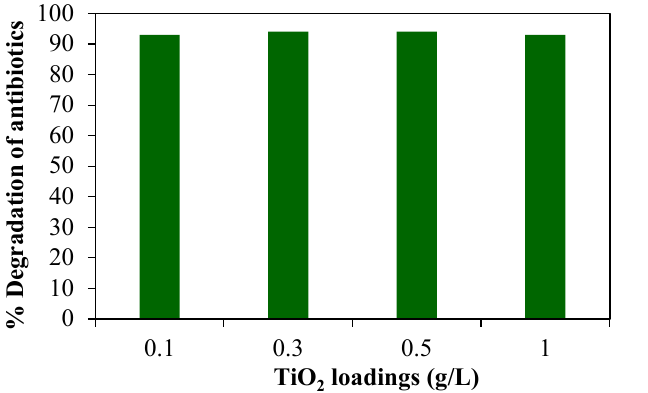
Figure 10. The effect of TiO 2 loadings on the degradation of total antibiotics after 60 min UV illumination at different TiO 2 loadings.